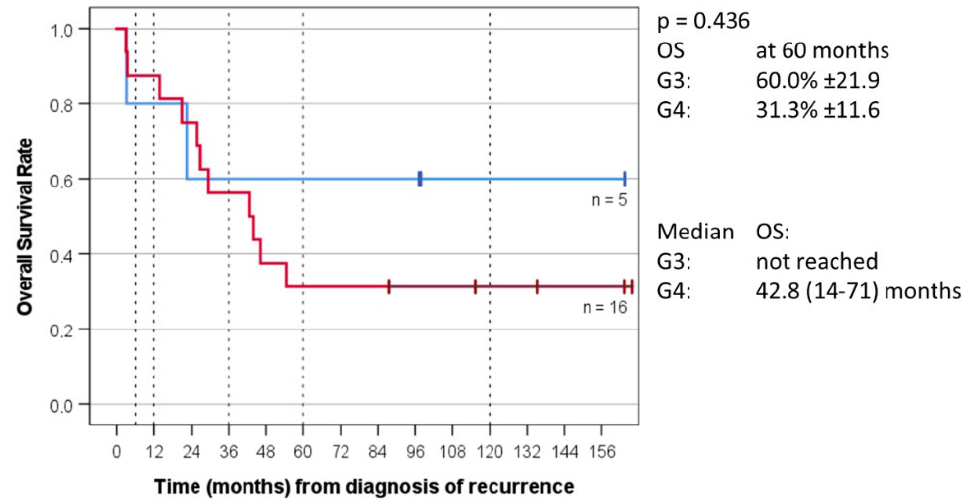
Figure 5. Overall survival (OS) of MB_G3 versus MB_G4 of 21 patients with recurrent non- WNT/non-SHH medulloblastoma for which molecular group was known.